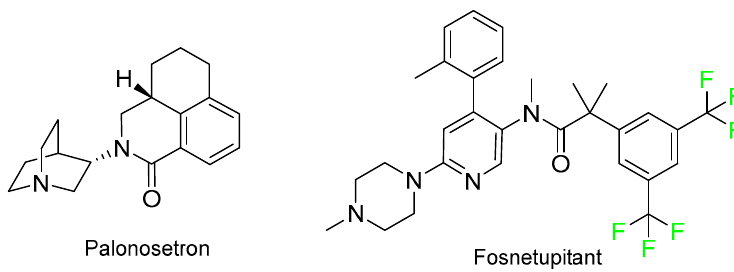
Figure 10. Structure of Akynzeo ™ , a drug combination.